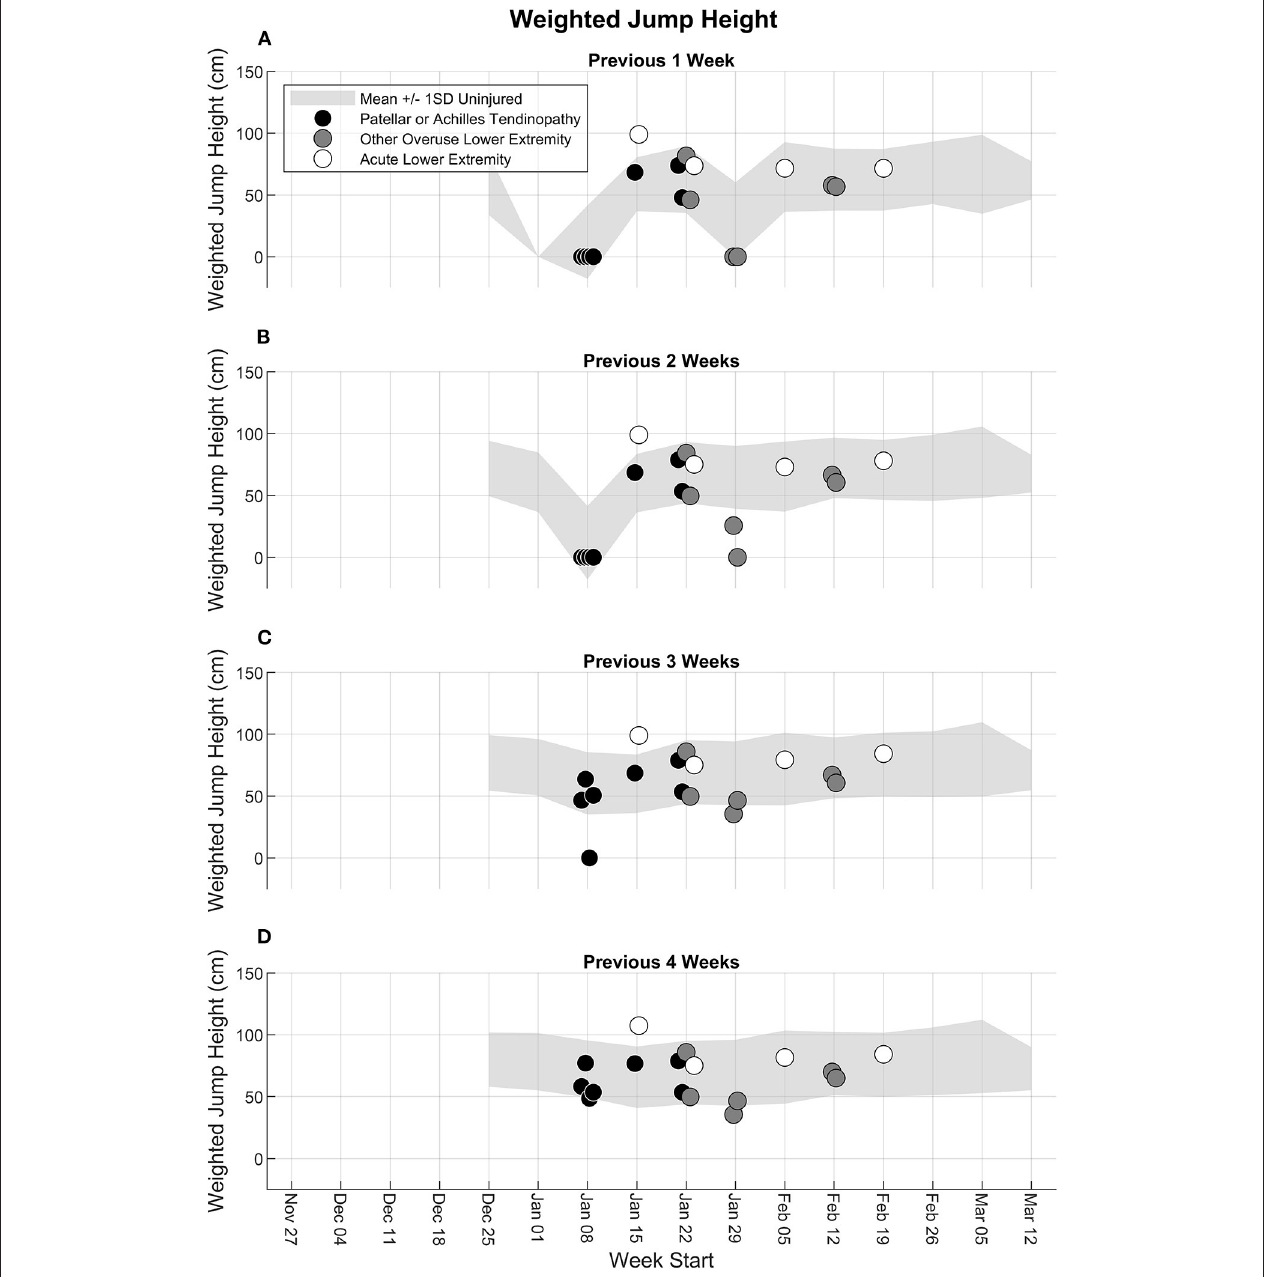
FIGURE 5 | Accumulated weighted jump height from the fifth week to the end of the season for the previous (A) 1 week, (B) 2 weeks, (C) 3 weeks, and (D) 4 weeks. Light gray shaded band represents the mean ± 1 standard deviation (SD) of all participants until the last week where they did not experience any injury. Participants with a lower extremity injury are shown separately in the week in which their first injury was reported, and the injury type is indicated as patellar or Achilles tendinopathy (black circle), other overuse lower extremity injury (dark gray circle), or acute lower extremity injury (white circle).